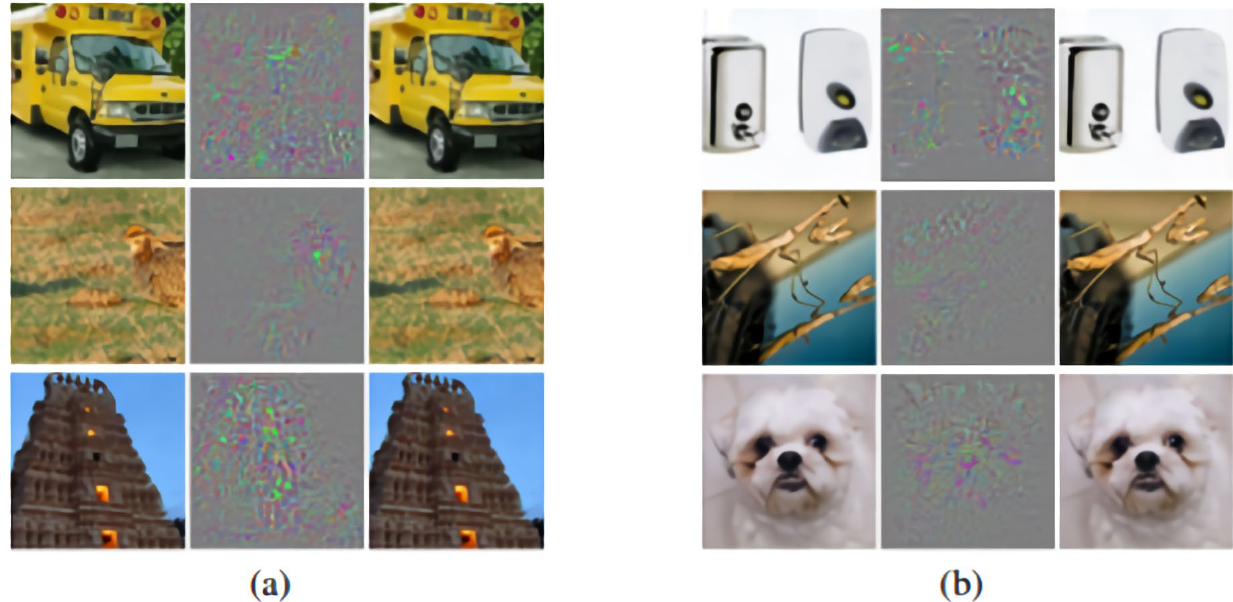
Figure 18. Adversarial examples by L-BFGS attack generated for AlexNet. All the images in the third columns of ( a ) and ( b ) were predicted to be “ ostrich, Struthio camelus ” .